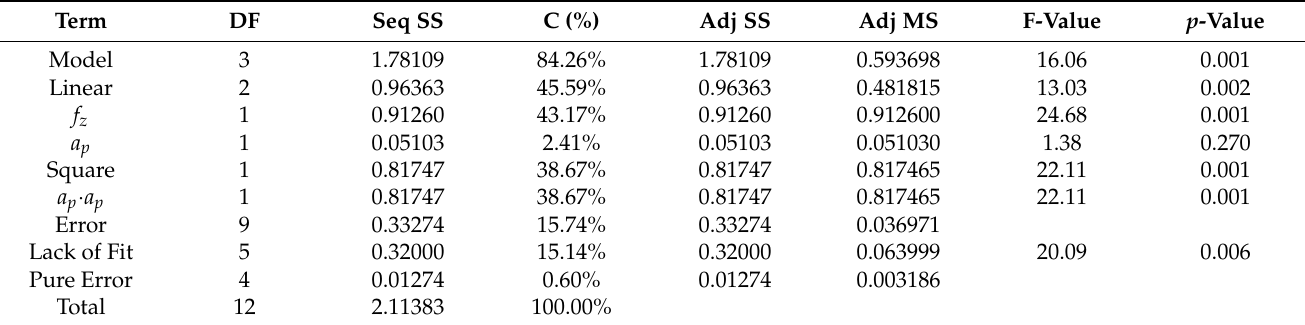
Figure 13. Surface roughness Rz parameter model. Table 8. Analysis of variance for the Rz surface roughness model.